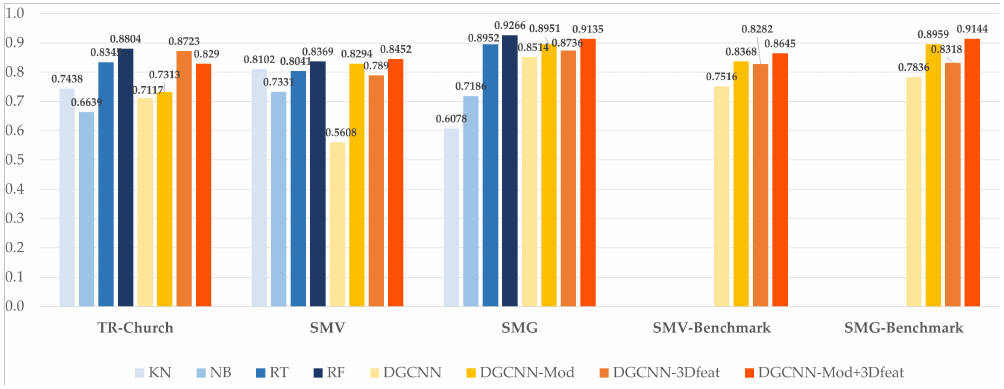
Figure 9. Overall Accuracy of all tests carried out.